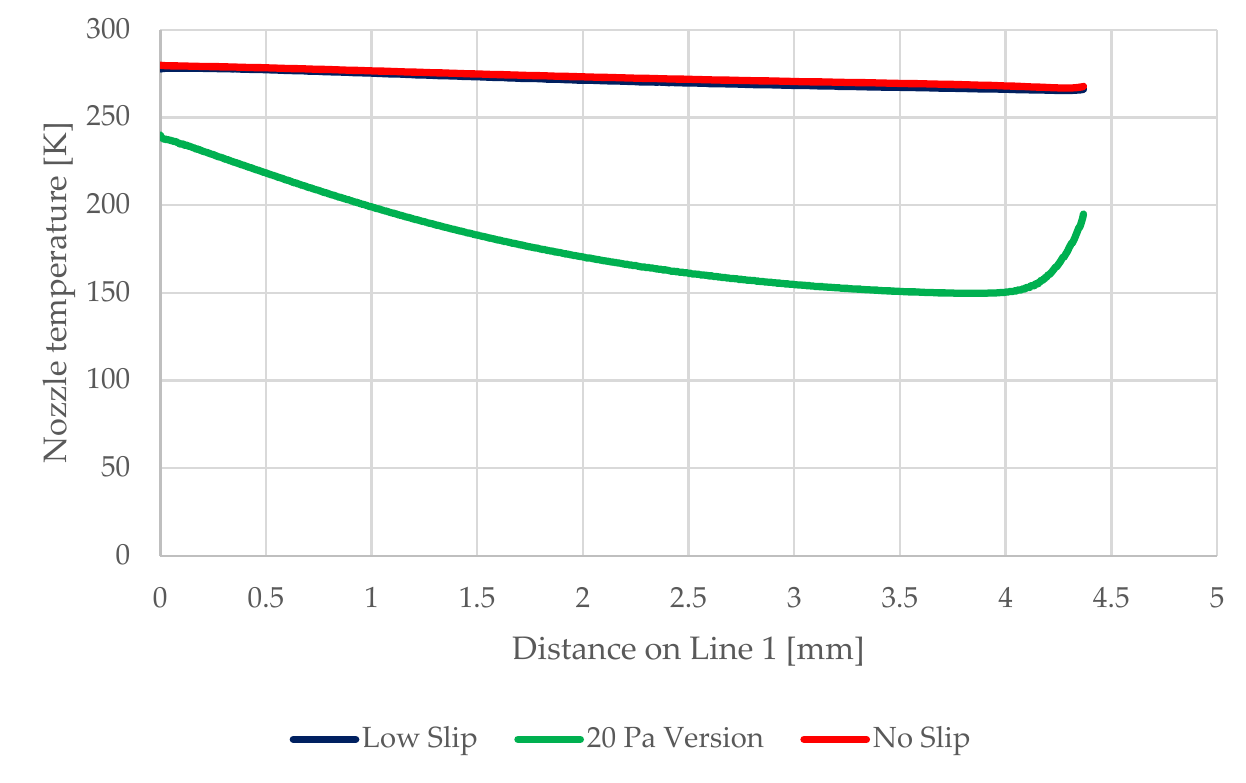
Figure 29. Temperature distribution on the nozzle wall in the experimental chamber.